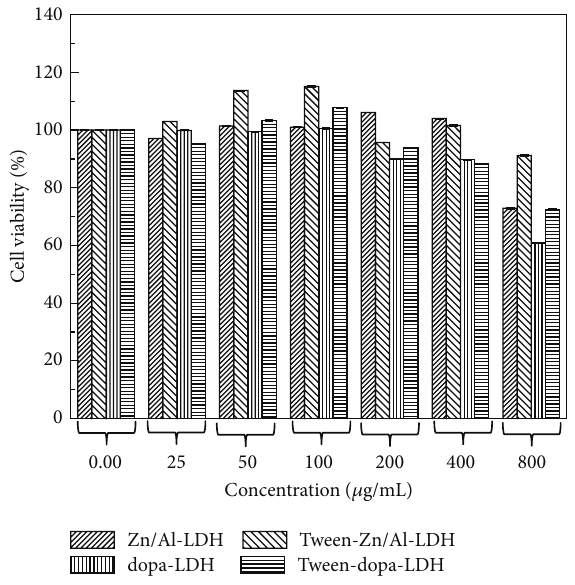
Figure 9: PC12 cell viability study using MTT assay. Treatment was done with the nanocomposite at doses 25–800 𝜇 g/mL for 72 hours. Statistically there is no significant difference between all the groups tested ( 𝑃 > 0.05 ) as tested by one-way ANOVA. Tween-dopa-LDH showed slightly higher viability than dopa-LDH at 200–800 𝜇 g/mL concentration. Tween-LDH also had less toxicity effect on the cell between 200–800 𝜇 g/mL concentrations.